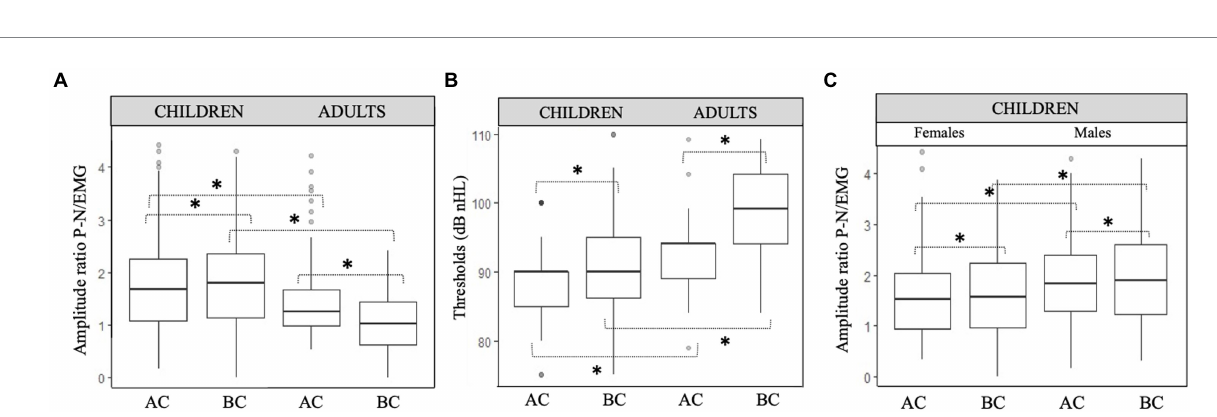
FIGURE 5 Comparison of c-VEMP characteristics in children and adults. (A) Amplitude ratio and (B) Thresholds (dB nHL) between children and adults and (C) amplitude ratio between males and females in children. Boxplots show median, lower and upper quartiles, and extreme values. Circles represent outliers. Paired t test with significant difference are indicated with a bracket and a star